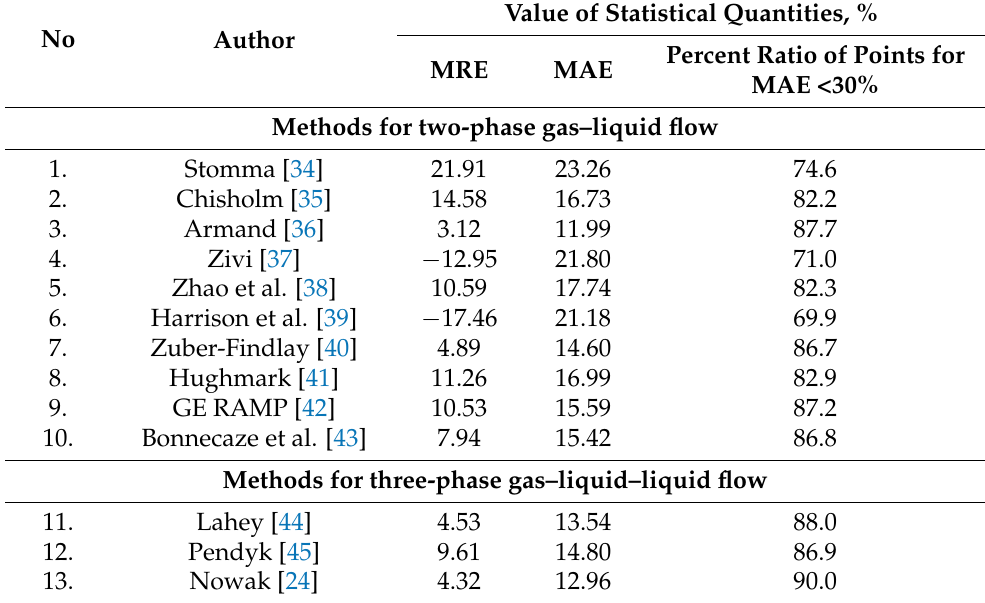
Table 7. Results of statistical analysis of methods applied to the calculation of α g